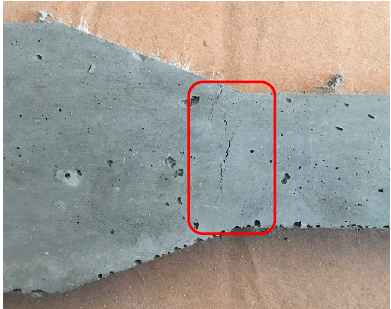
Figure 1. Initial cracks in a specimen caused by shrinkage stress.